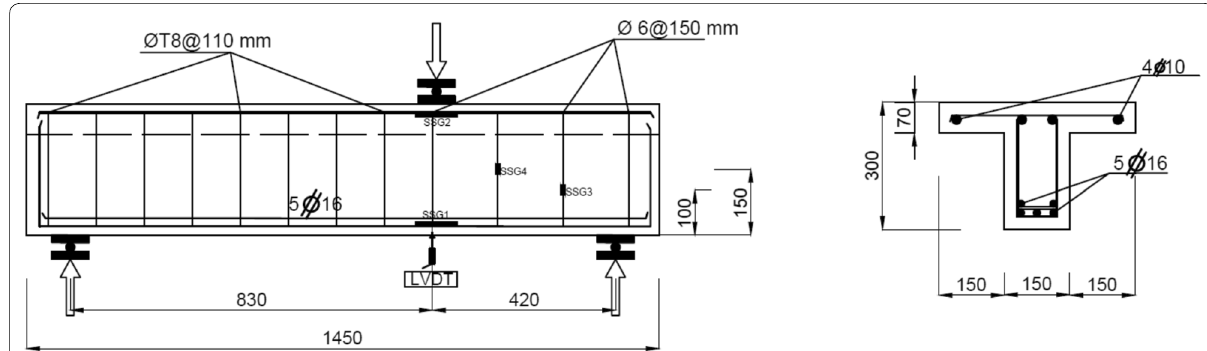
Fig. 1 Details of the beam specimen (all dimensions in mm).